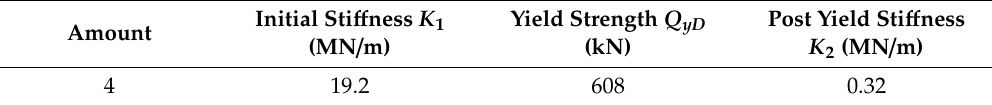
Table 5. Properties of selected steel dampers for